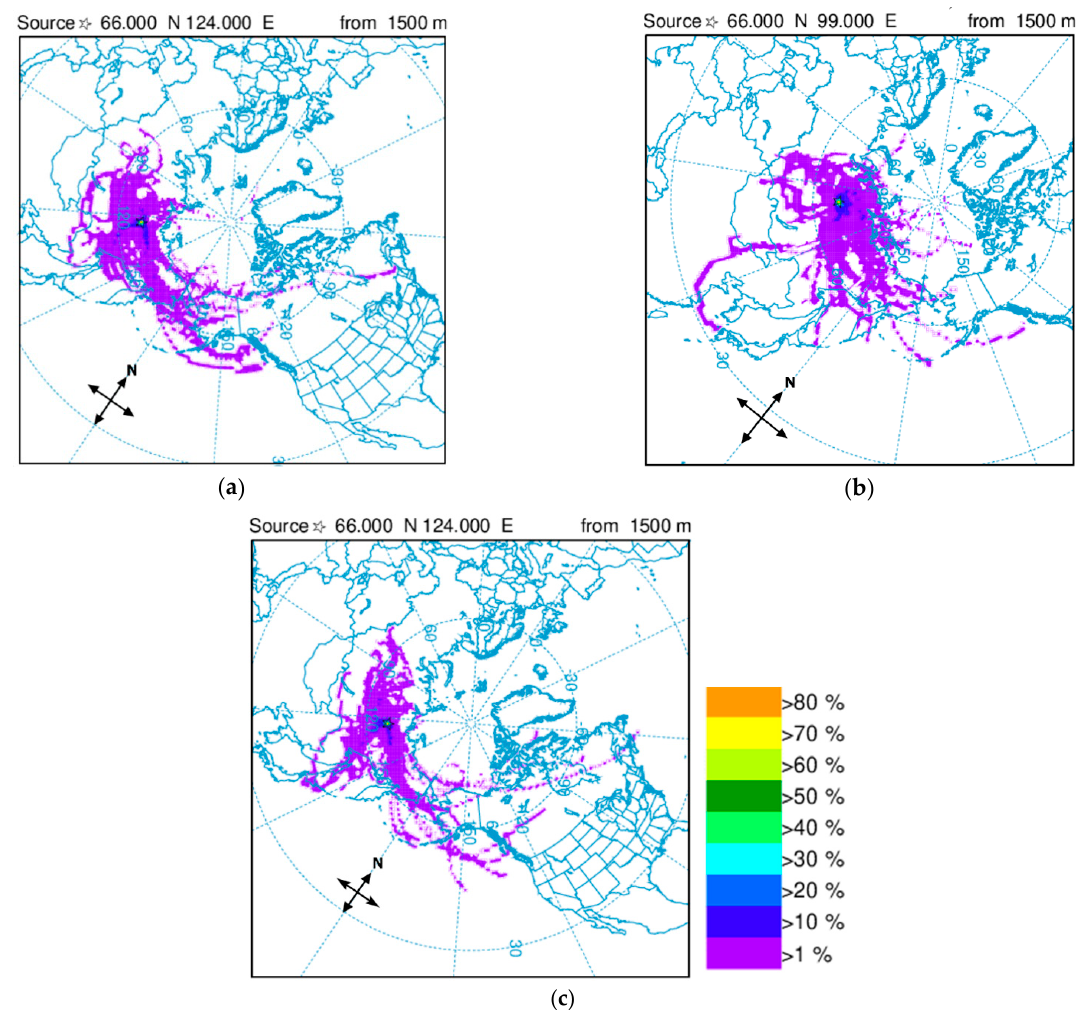
Figure 3. The probability of particle transfer: ( a ) from fire No. 1, ( b ) from fire No. 2, ( c ) from fire No. 3 (see Table 2), calculated using the Hysplit trajectory model.